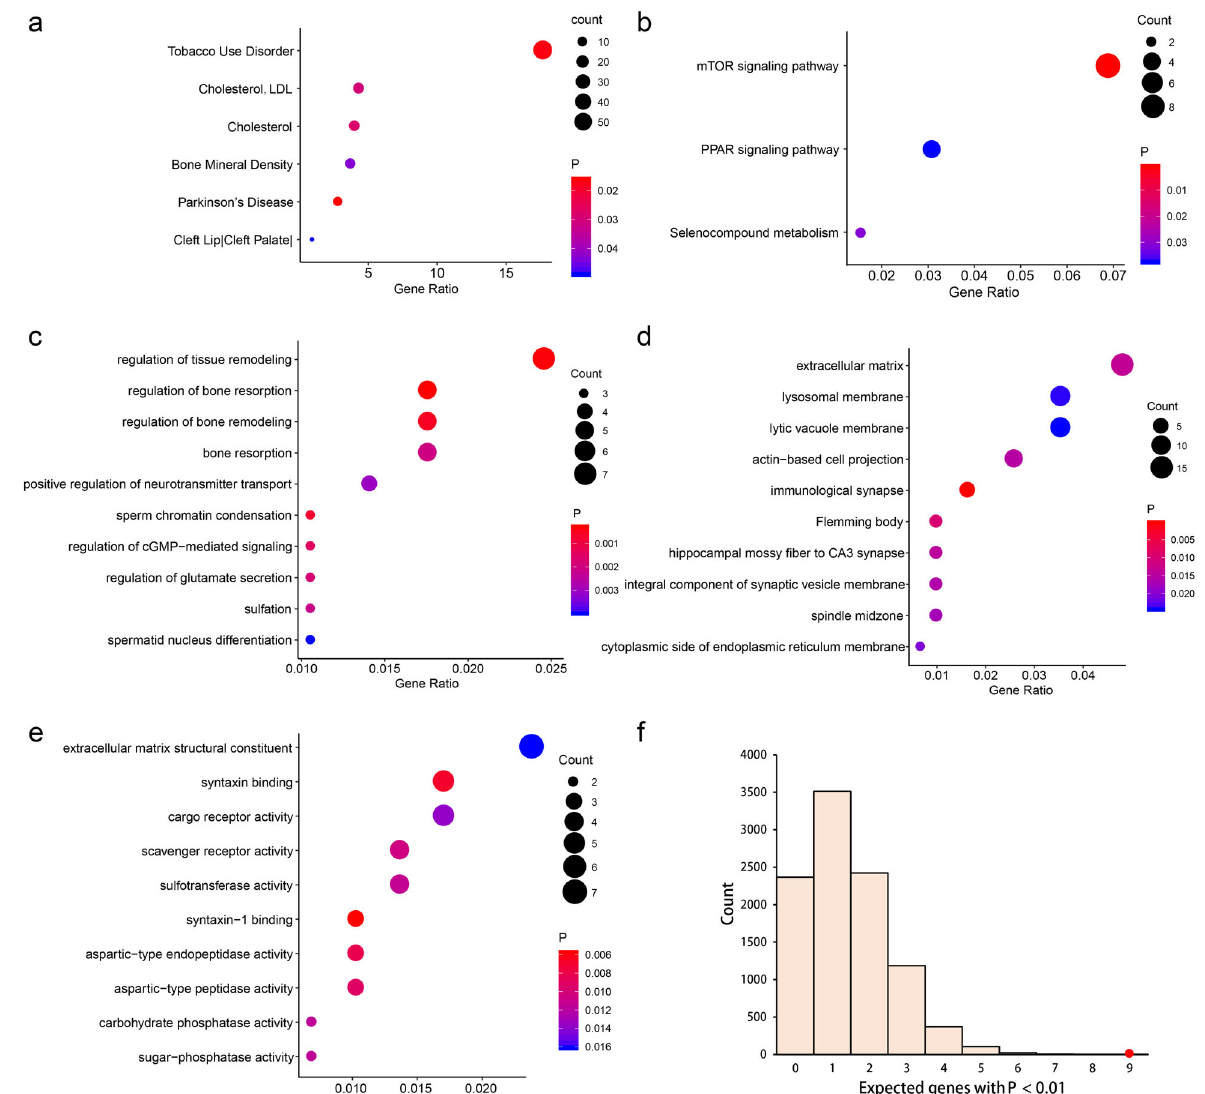
Fig. 4 Pathway enrichment results of TWAS-identi fi ed genes. a GAD disease enrichment analyses of TWAS genes. b KEGG pathway enrichment analyses of TWAS genes. c – e Top ten GO terms enriched in TWAS genes, including biological processes ( c ), cellular component ( d ), and molecular function ( e ). f GWAS Catalog enrichment analyses of TWAS genes. The histogram shows the expected number of genes with P < 0.01 based on 10,000 random permutations. The large red point shows the observed number of previously known PD genes that fall below this threshold.